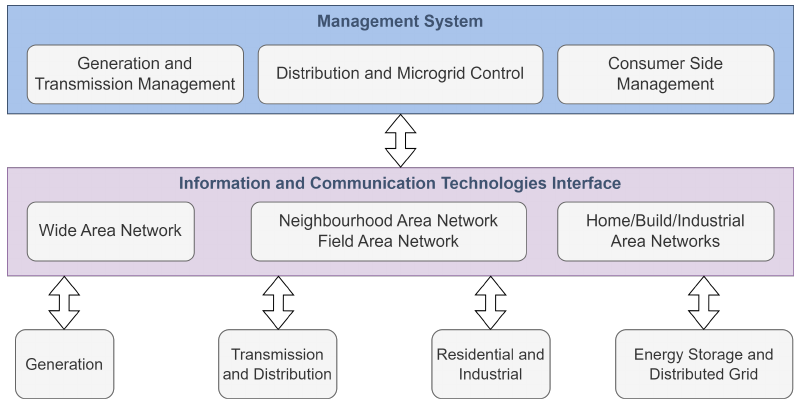
Figure 1. Smart Grid infrastructure and